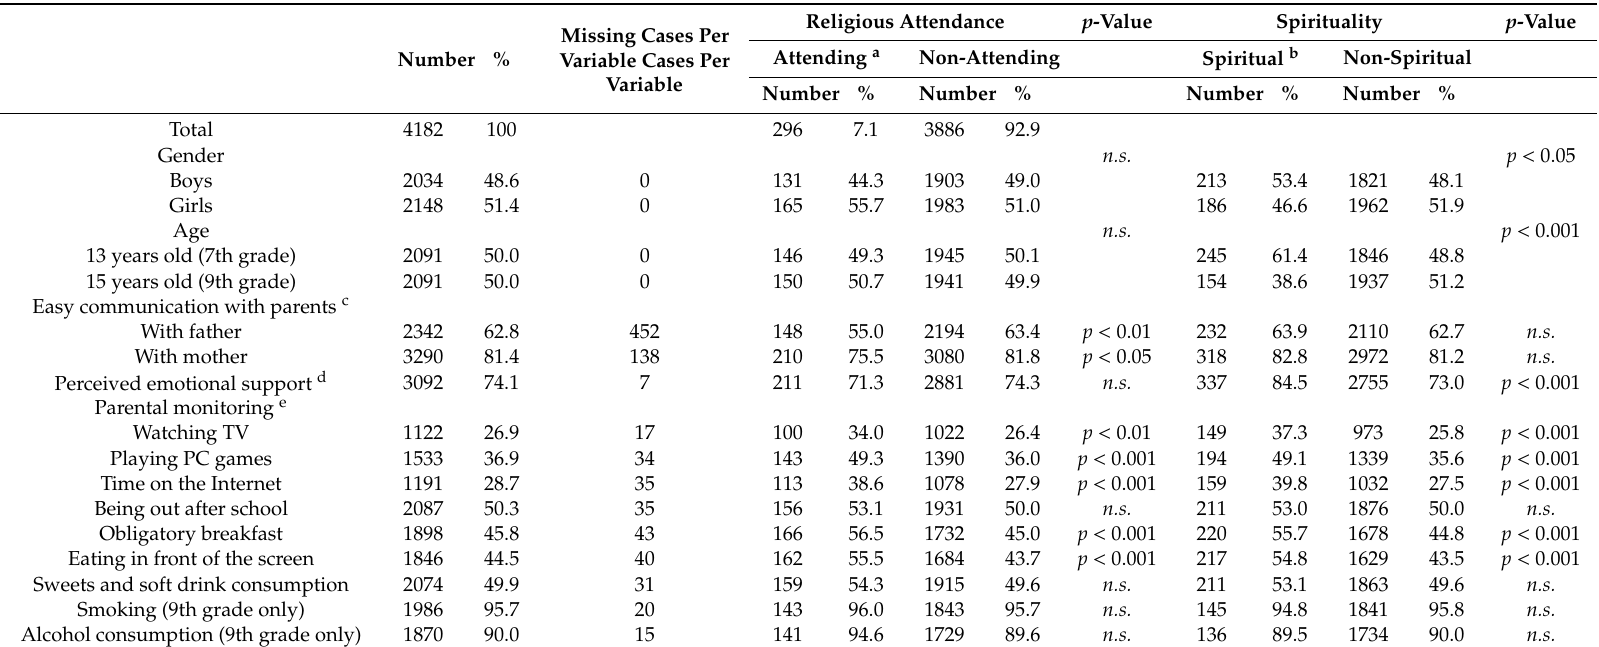
Table 1. Sample characteristics by religious attendance and